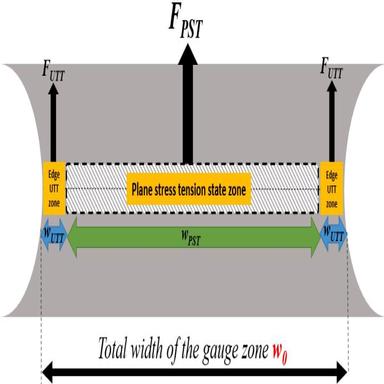
Schematic representation of the equilibrium state of different loads in the gauge section of the RHPST specimen.